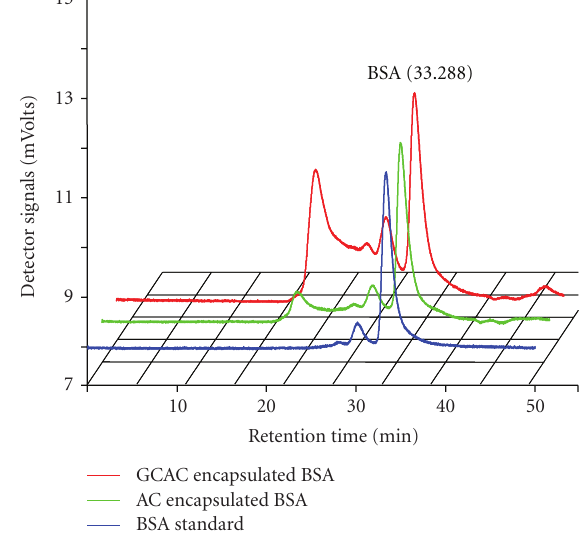
Figure 10: Di ff usion of FITC-dextran into microcapsules as a function of dextran molecular weight.